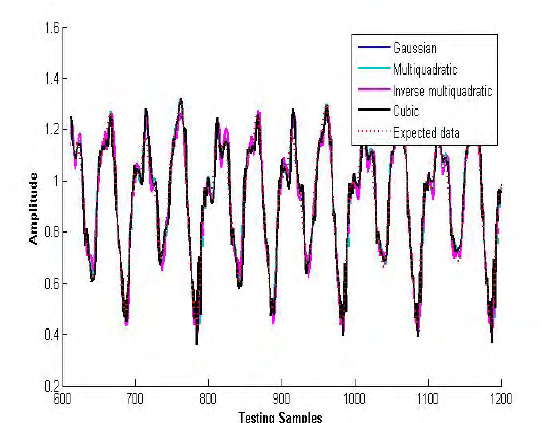
Fig. 12. Testing the individual NARX-RBFNNs - Mackey